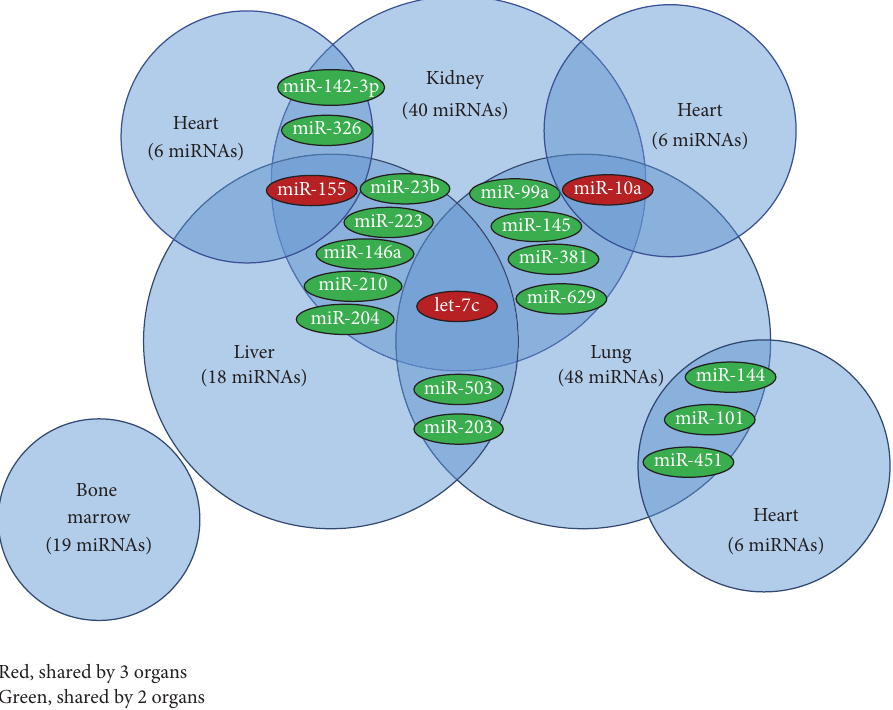
Figure 2: Comparison of overlapping miRs in the different studies. Color-labeled miRs indicate a miRNA shared by 2 (green) and 3 (red) organs, respectively. The number in parentheses represents nonoverlapping miRNAs detected for the corresponding